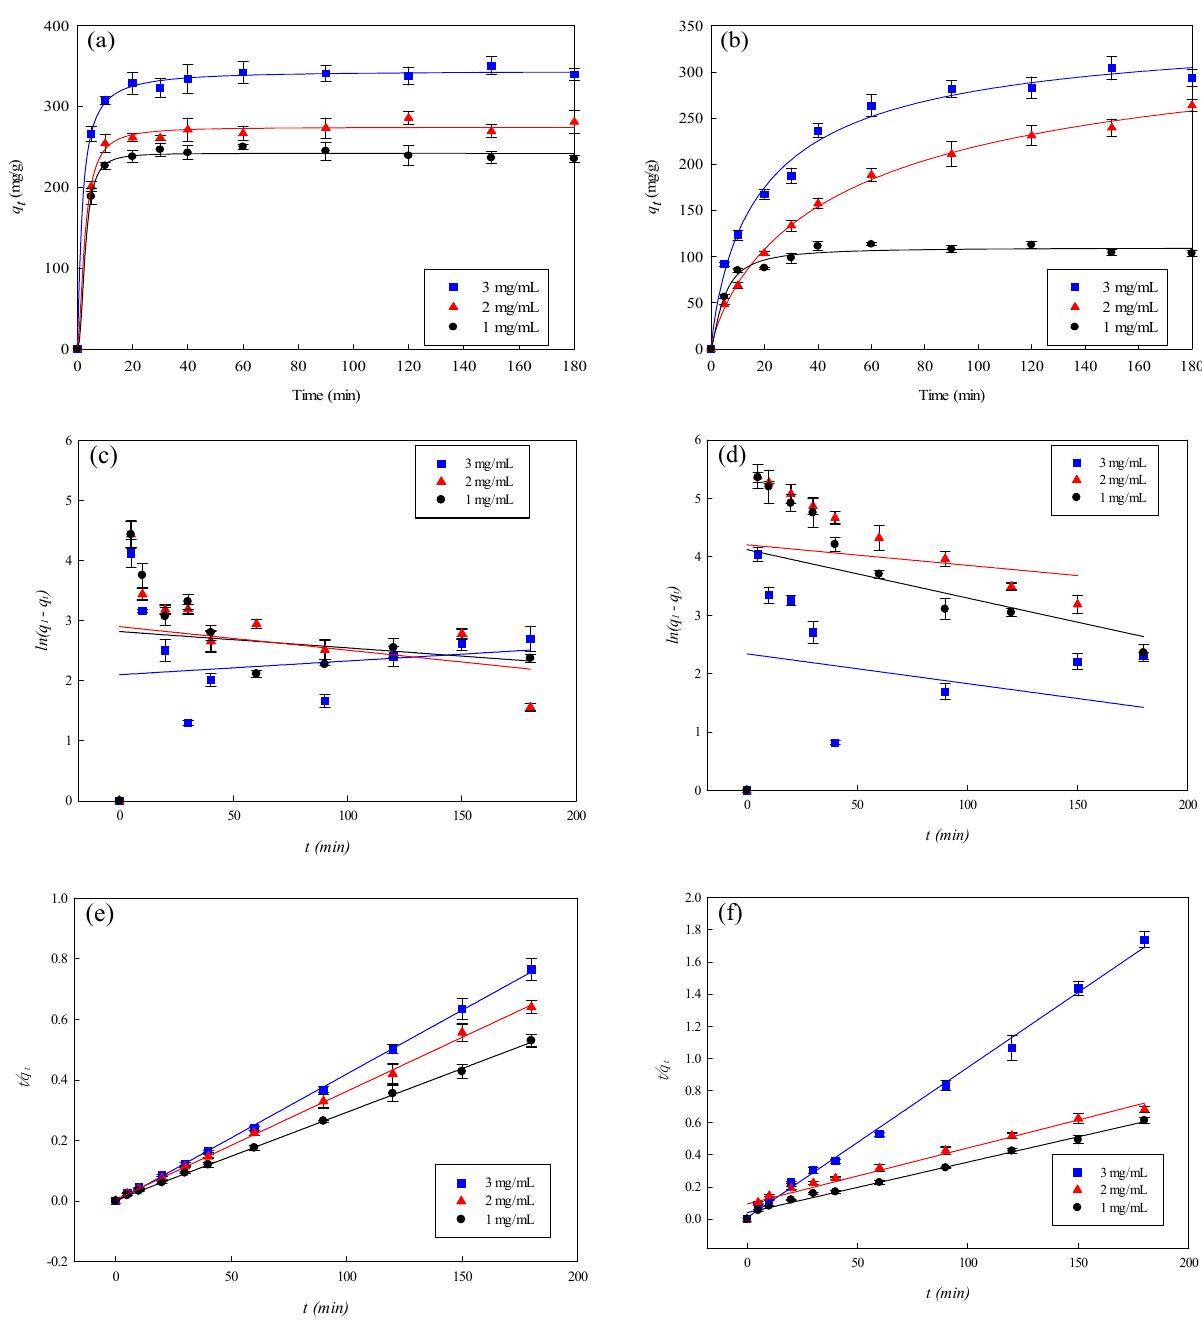
Figure 9. Adsorption rates of P-COOH-CS-CEW nanofiber membrane for ( a ) AO7 and ( b ) TBO dyes. Kinetic adsorption of ( c ) AO7 and ( d ) TBO fitted by pseudo first-order model. Kinetic adsorption of ( e ) AO7 and ( f ) TBO fitted by pseudo second-order model. Table 2. Pseudo first-order and pseudo second-order kinetic rate constants, calculated and experi- ment q values for the adsorption of AO7 and TBO dyes onto the P-COOH-CS-CEW nanofiber mem- brane at different dye concentrations.